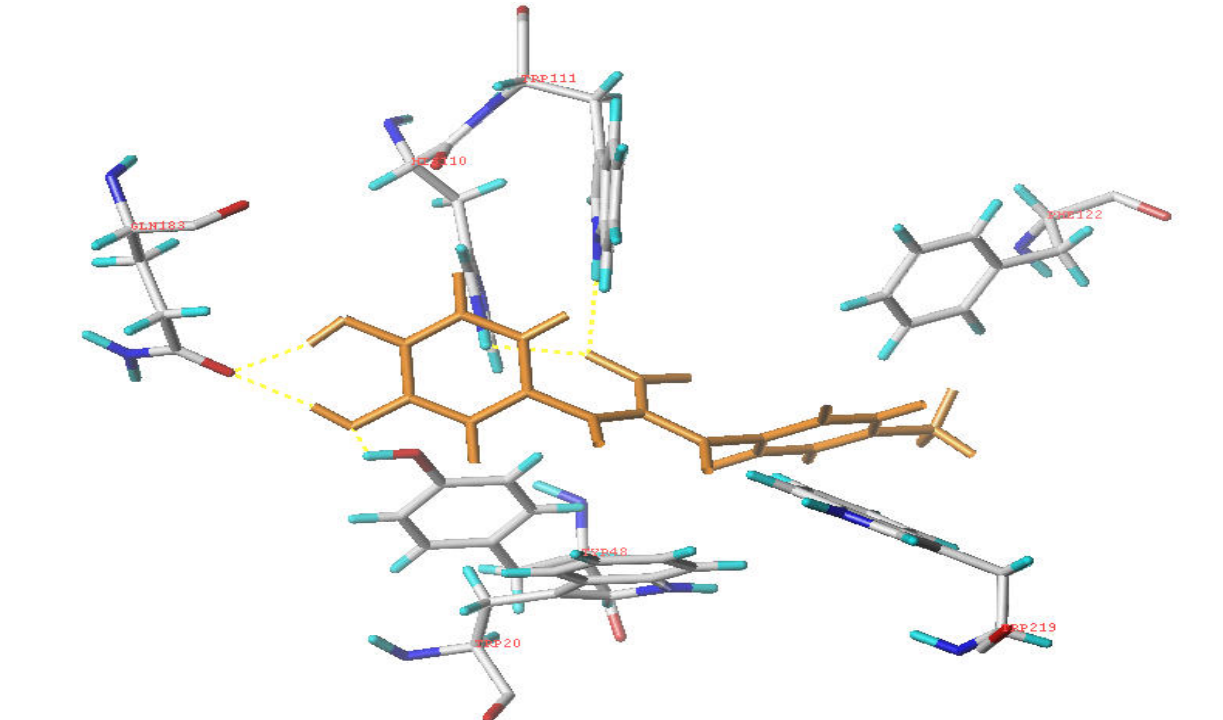
Figure 2. Amino acid residues interacting with compound 3k (orange) in the structure of the enzyme-inhibitor complex. Hydrogen bonds are represented by dashed yellow lines